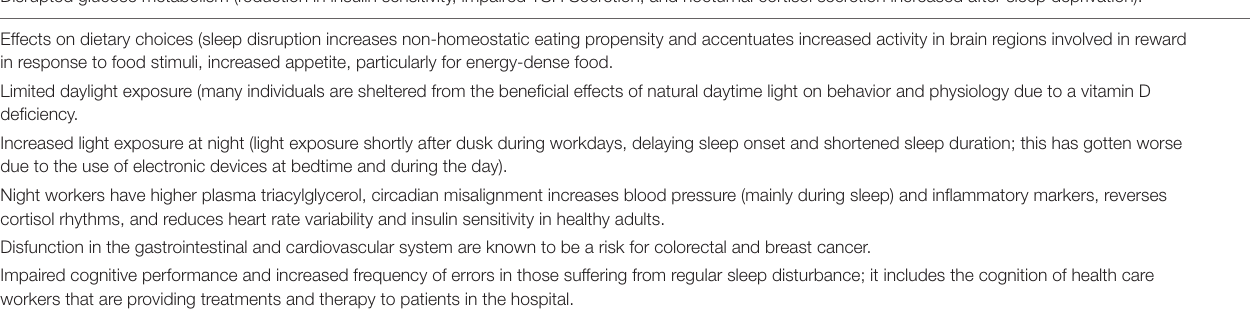
TABLE 1 | Consequences of the disruption of circadian